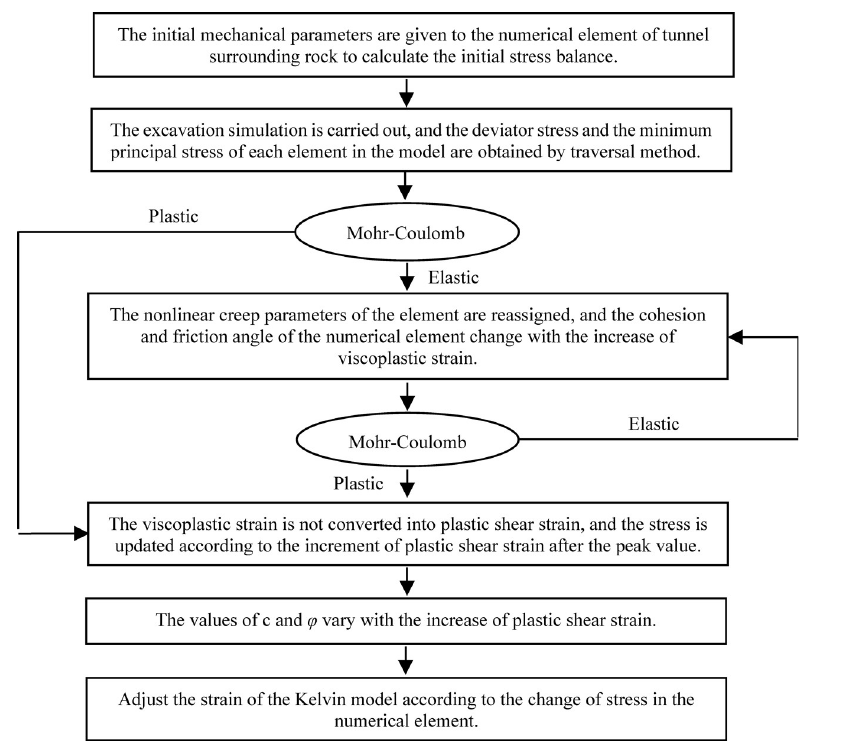
Fig 12. Numerical calculation flow chart of the coupled effect of creep and strain-softening. .